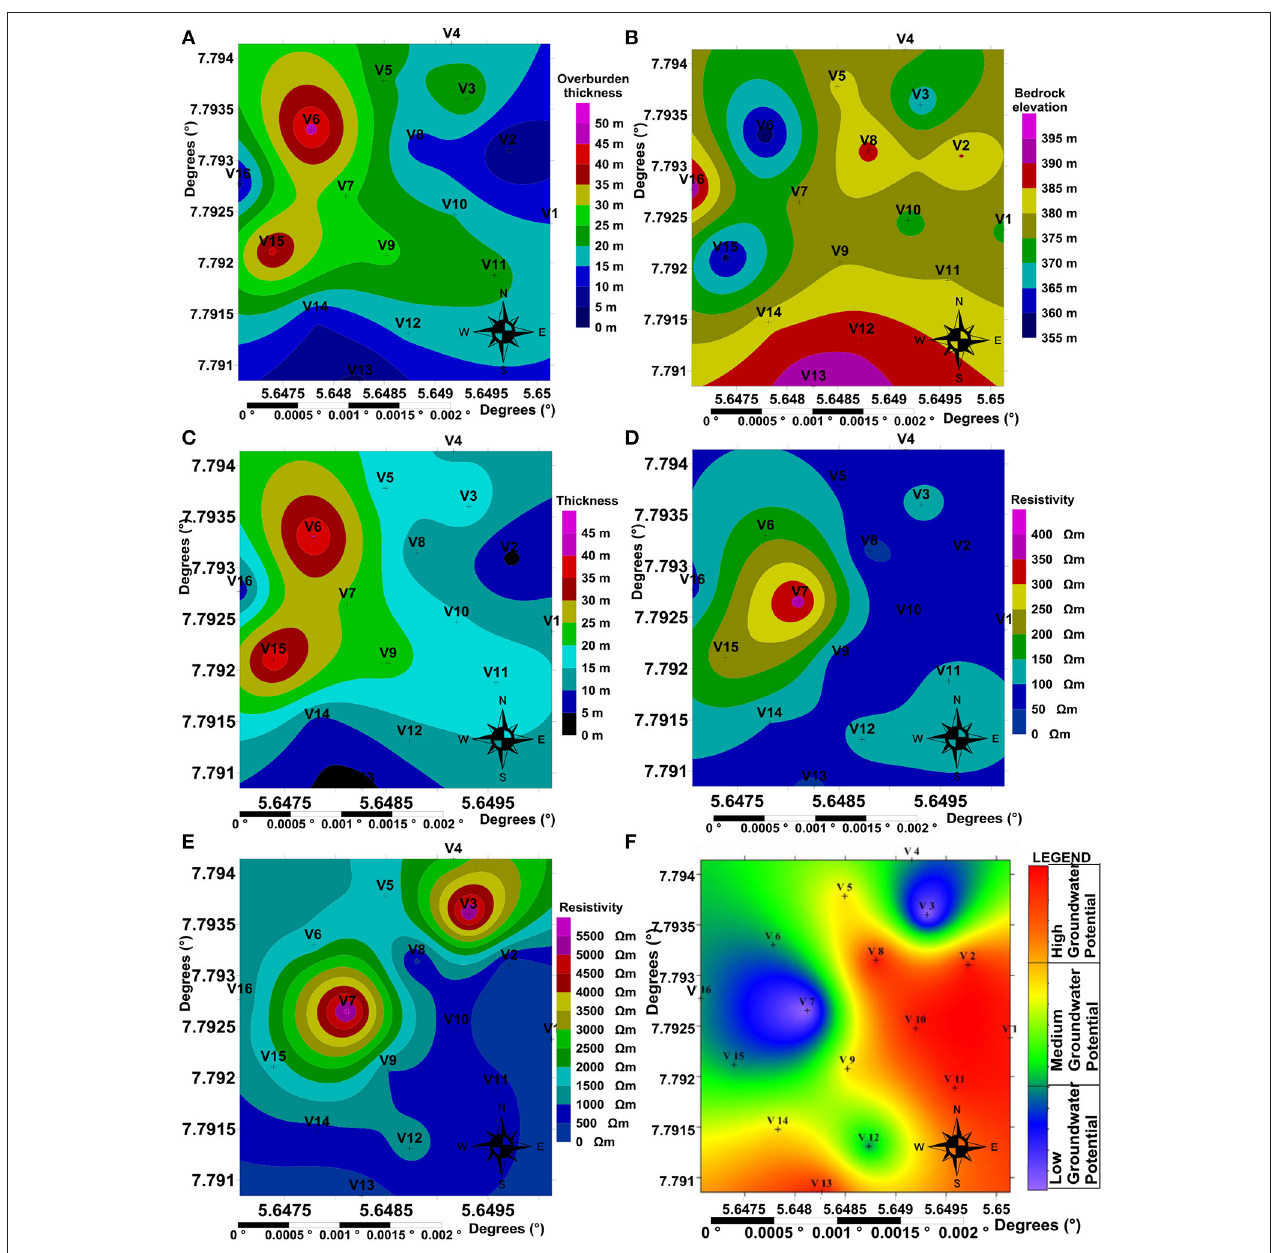
FIGURE 4 | Maps of various groundwater related parameters. (A) Overburden Isopach Map. (B) Bedrock Relief Map. (C) Weathered Layer Isothickness Map. (D) Weathered layer isoresistivity map. (E) Bedrock isoresistivity map. (F) Final Groundwater potential